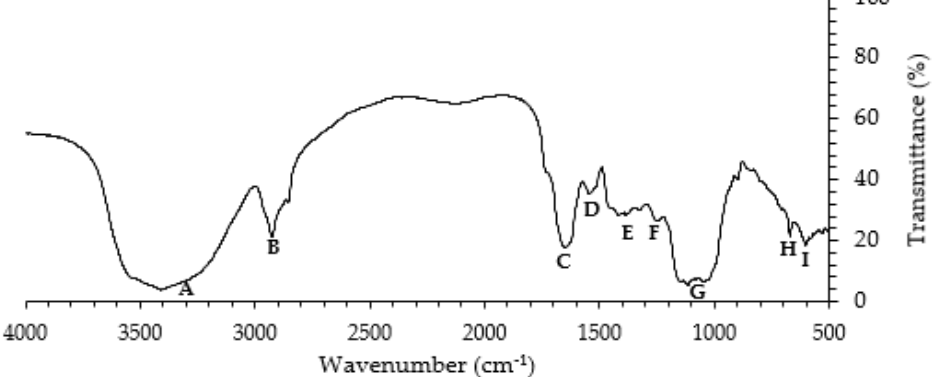
Figure 2. Fourier transform infrared (FT ‐ IR) spectrum of alder